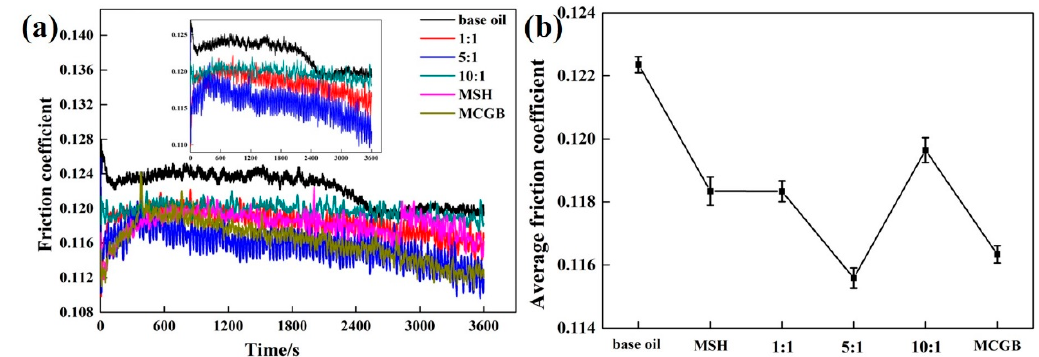
Figure 4. ( a ) The friction coefficient curves of ML-MSH/CGB oil with different proportions depending on friction time; and ( b ) average friction coefficient of ML-MSH/CGB oil as a function of proportion.